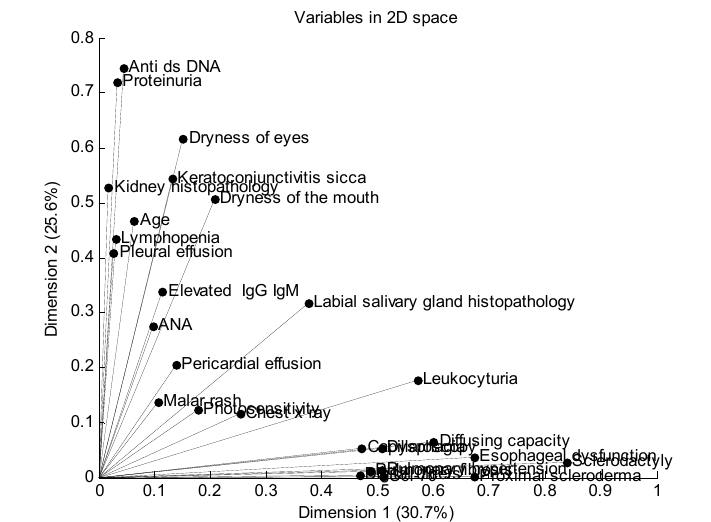
Figure 2 – Discrimination measure plot, 2D solution Рис . 2 – Изображение 2 Д решения , при применении дискриминативных